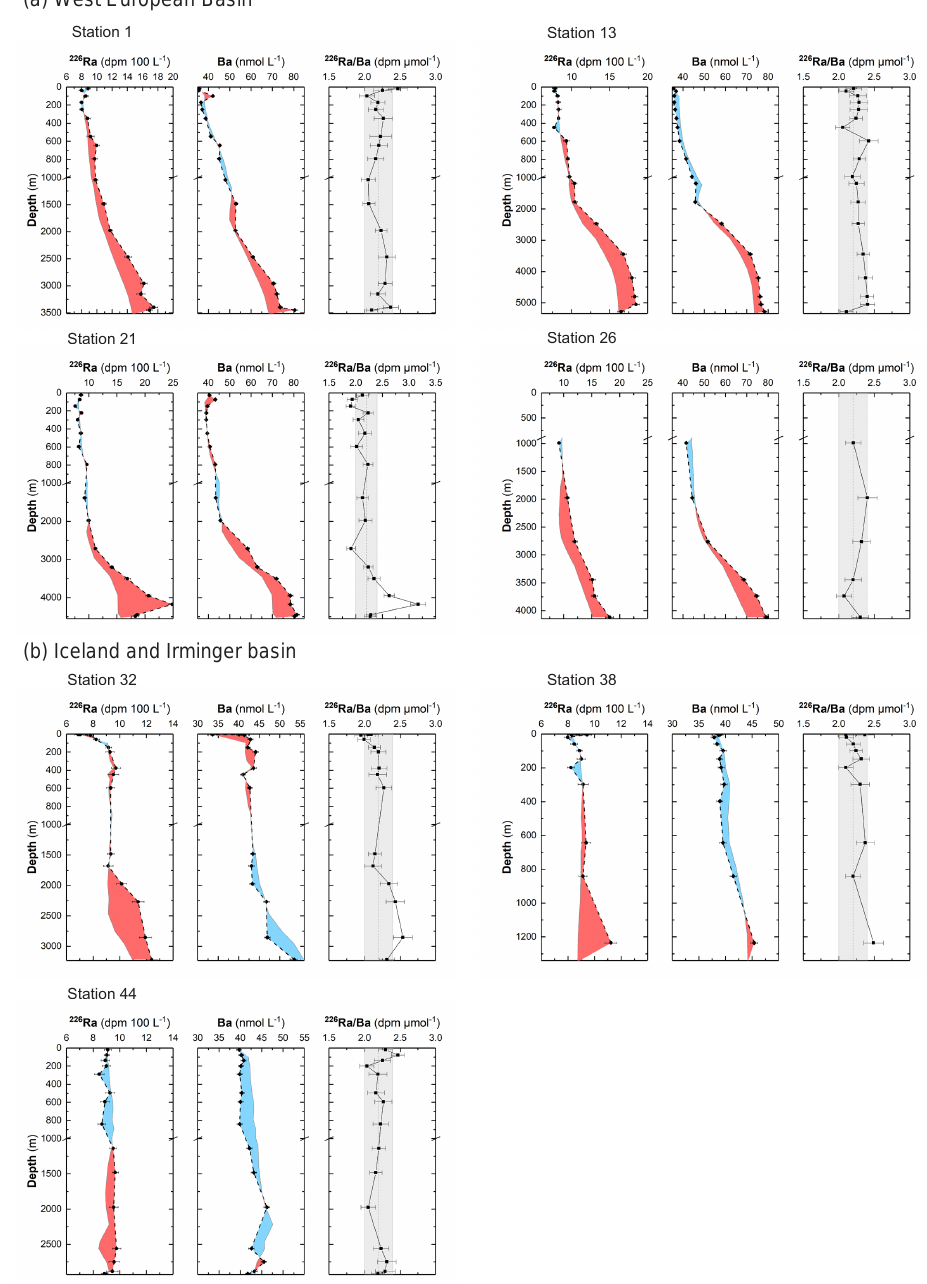
Figure 7. Vertical profiles of dissolved 226 Ra activities and Ba concentrations determined along the GA01 section: (a) West European Basin, (b) Iceland Basin and Irminger Basin, (c) the Greenland and Newfoundland margins and (d) Labrador Basin. As a comparison, the conservative 226 Ra and Ba vertical profiles derived from the OMP analysis are also shown as solid grey lines. The discrepancy between the two vertical profiles indicates deviation from the conservative behavior and reflects either an input of 226 Ra or Ba (positive anomalies highlighted in red; same color code as Fig. 6) or a removal of 226 Ra or Ba (negative anomalies highlighted in blue; same color code as Fig. 6). The OMP analysis has not been solved for the shallow coastal stations 53, 61 and 78. The 226 Ra / Ba ratios are also reported, together with the mean GEOSECS 226 Ra / Ba ratio (2.2 ± 0.2dpmµmol − 1 ; black dashed line) and its 1 standard deviation (grey shaded areas). Note that the scale may be different from one station to another and the vertical axis was cut to 1000m. The seafloor is represented by the bottom